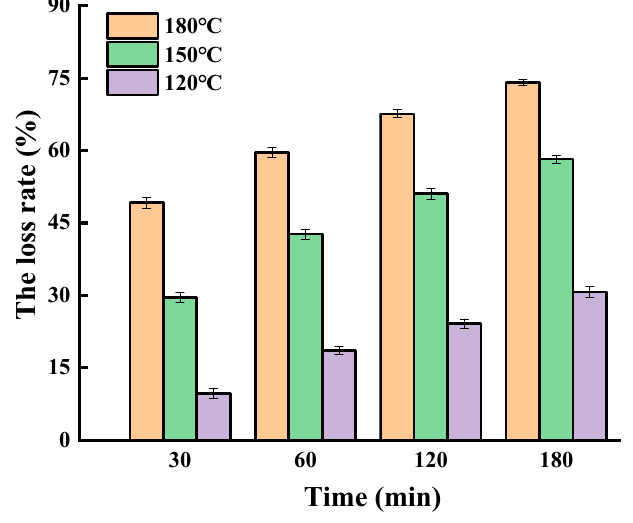
Figure 2. The loss rate of soybean germ phytosterols in soybean germ oil.